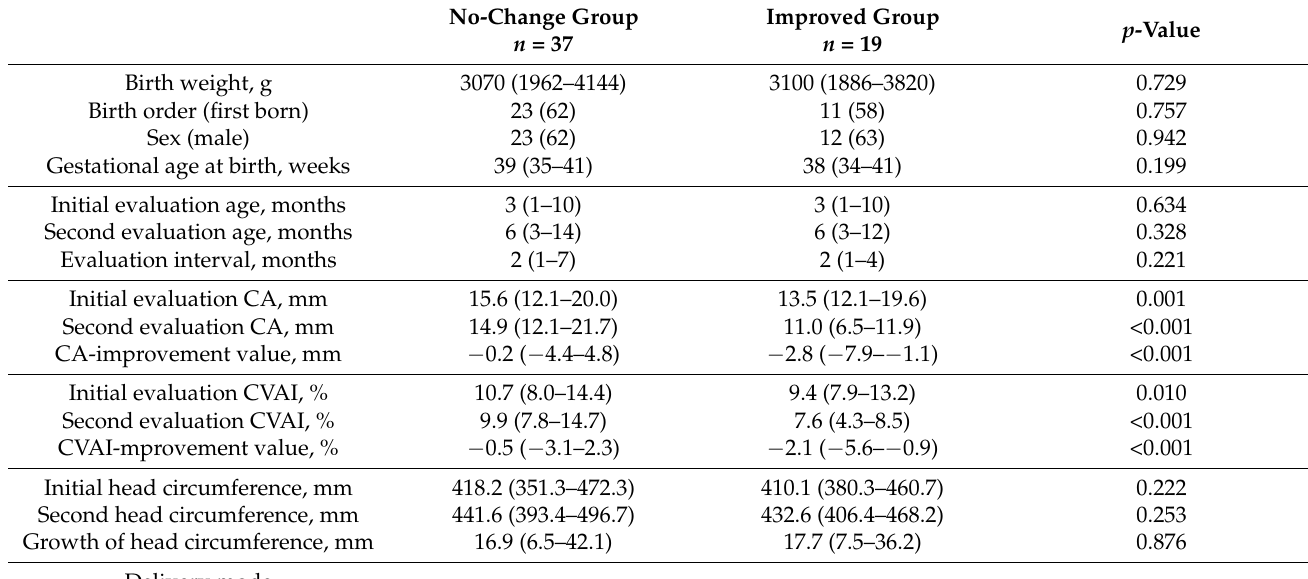
Table 1. Comparisons between the no-change and improved groups in the natural course of severe plagiocephaly. No-Change Group Improved n = 37